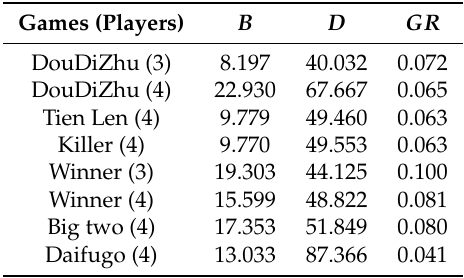
Table 13. DouDiZhu similar card games over the